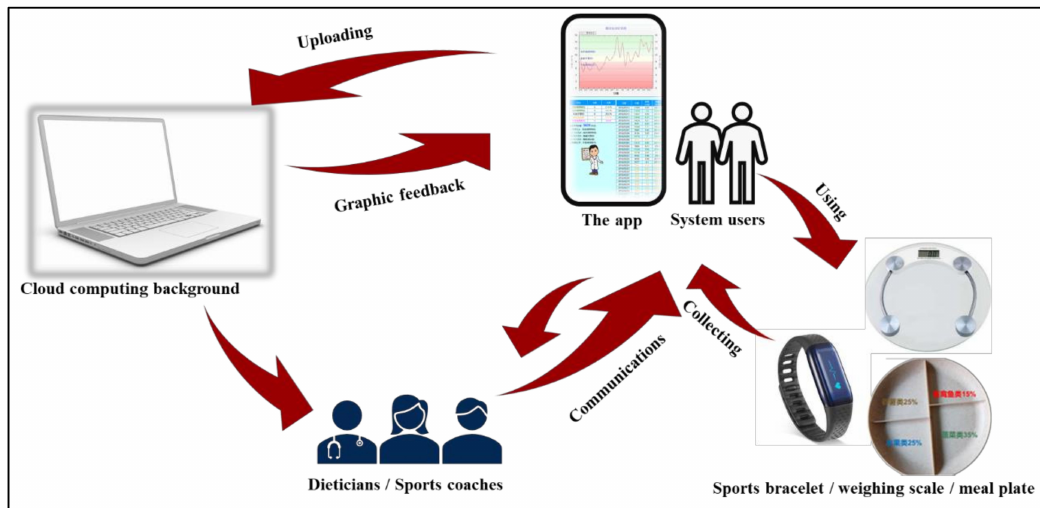
Figure 1. Illustration of the mobile-based support